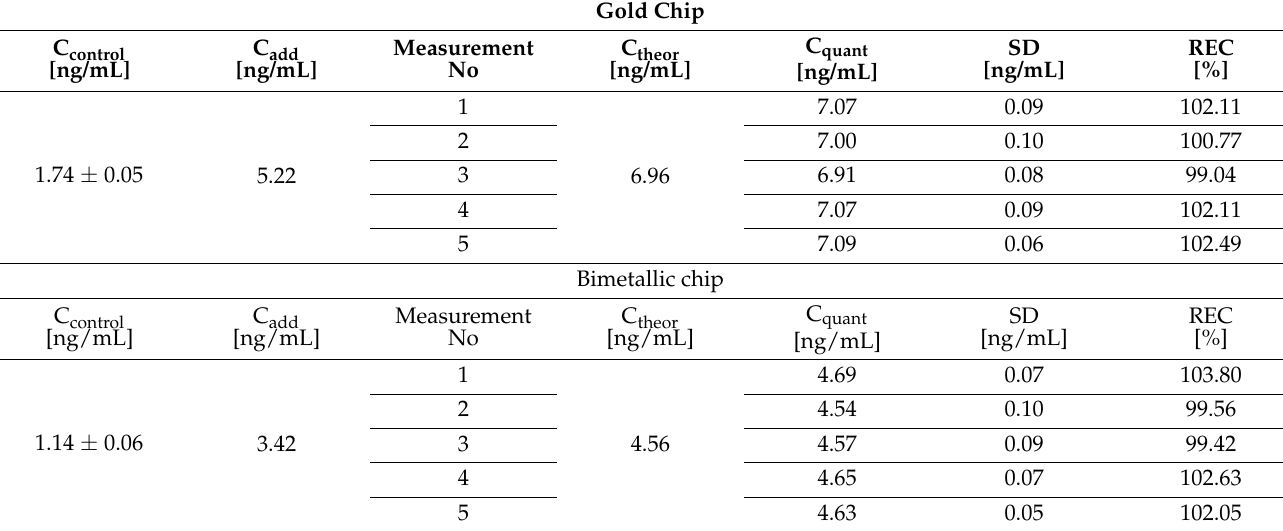
Table 4. Recovery by the method of standard